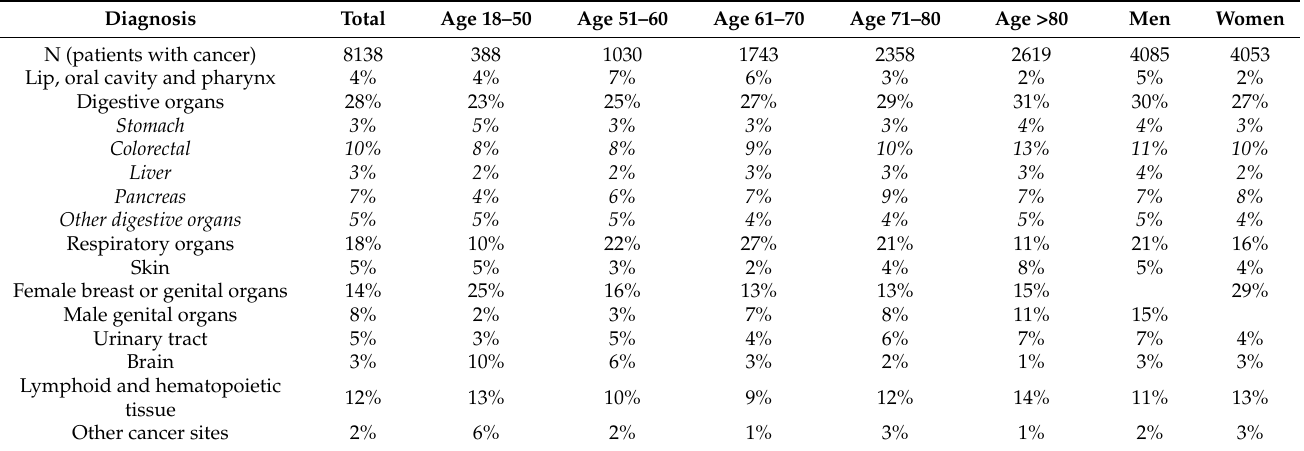
Table 2. Proportion of different tumor entities among cancer patients receiving palliative care in Germany between 2018 and 2021 stratified by sex and